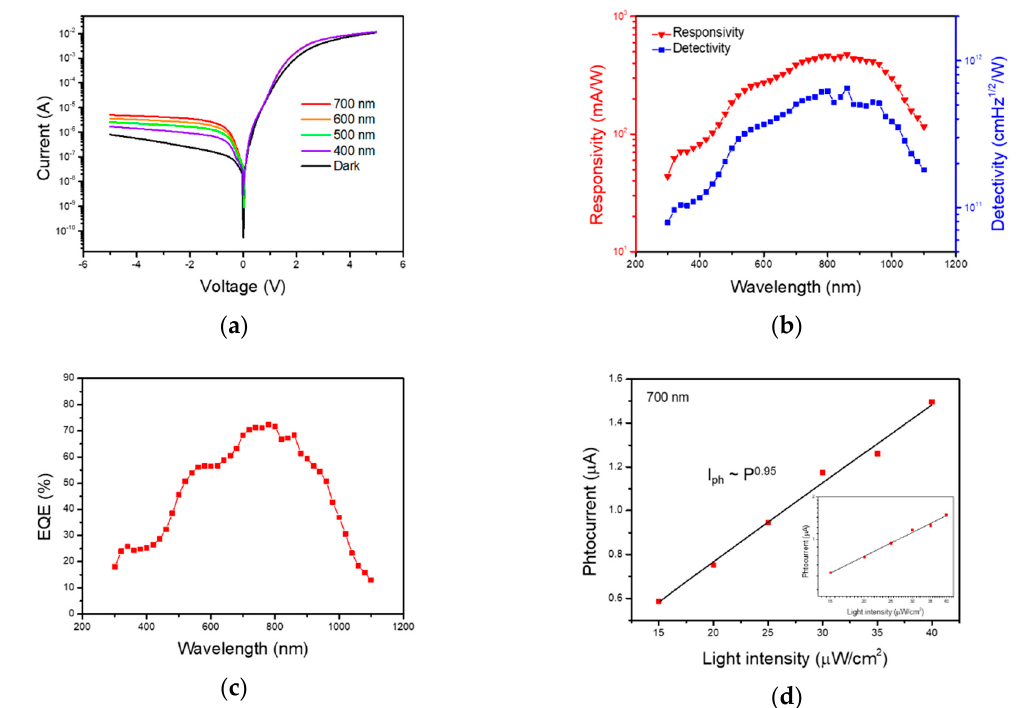
Figure 5. ( a ) I-V measurement comparison at the different visible wavelengths and light intensity of 50 µ W / cm 2 . ( b ) Wavelength dependent responsivity, detectivity, and ( c ) EQE. ( d ) Light intensity versus photocurrent graph in linear scale and semi-log scale (inset).